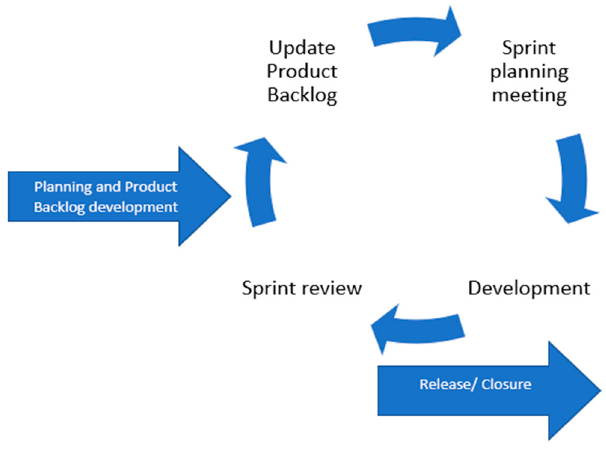
Figure 1. Scrum process illustration.